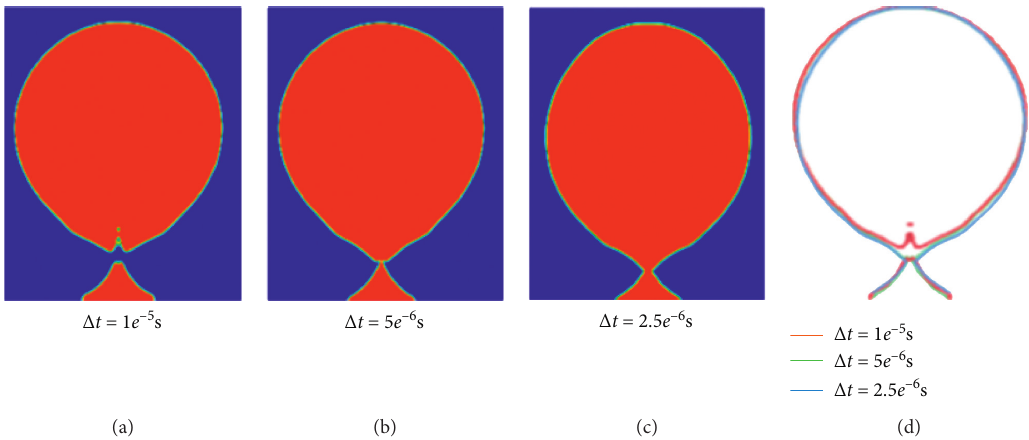
Figure 18: Simulation results at detachment time with different time steps: (a–c) the bubble snapshots at detachment time with different time step sizes; (d) the comparison of the bubble profile with different time step sizes (3) (Appendix